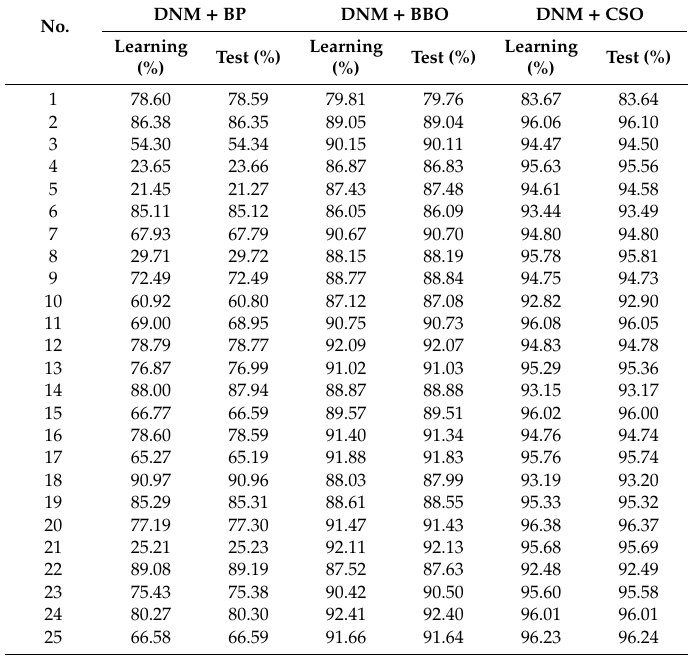
Table A2. Average accuracy of the learning and tests of each learning algorithm in F2.